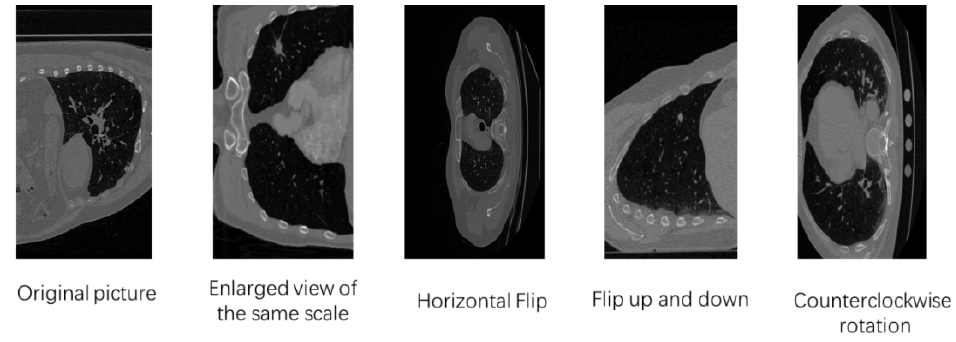
Figure 8. A sample of the data augmentation images.